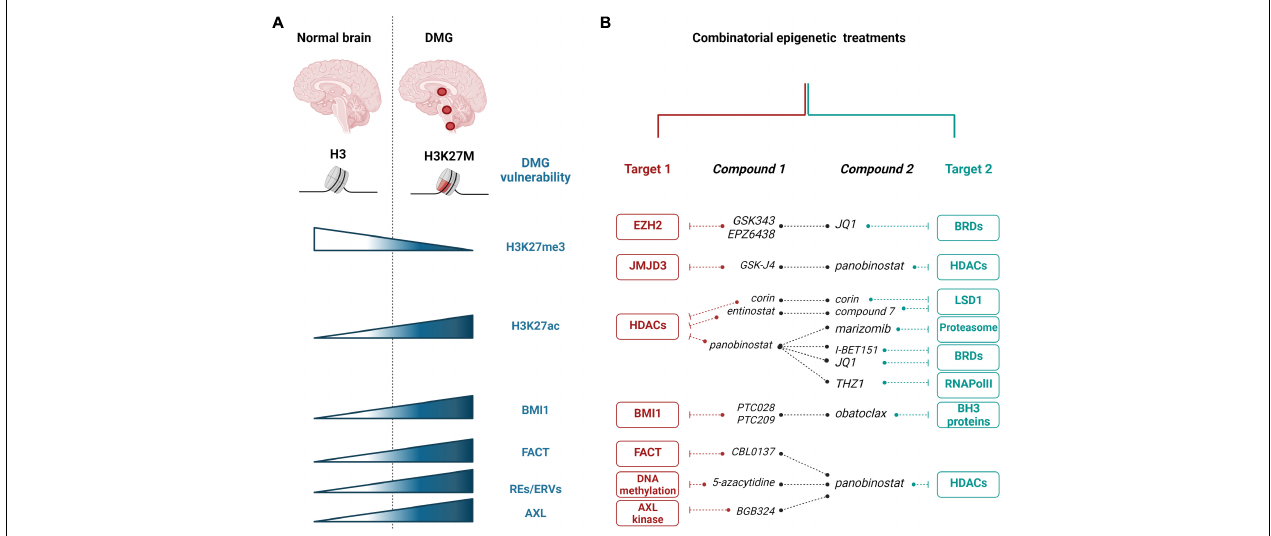
FIGURE 1 | Epigenetic targeting of H3K27M diffuse midline gliomas (DMGs). (A) Most of DMGs (localizing to the thalamus, brainstem, or spinal cord) are characterized by H3K27M substitution. The mutation leading to H3K27M is responsible for numerous changes in DMG cells, including the decrease in H3K27me3 and the increase in H3K27ac histone modifications, and increased expression of BMI1, FACT, and REs/ERVs. (B) Epigenetic vulnerabilities of H3K27M DMGs were targeted with epigenetic enzyme inhibitors and showed promising effects in preclinical studies using in vitro and in vivo models. Red and teal colors showed various targets that are inhibited with specific compounds in combinatorial treatments, as indicated. EZH2, enhancer of zeste homolog 2; JMJD3, Jumonji domain-containing 3; HDACs, histone deacetylases; BRDs, bromodomain containing proteins; LSD1, lysine-specific demethylase 1; RNAPolII, RNA Polymerase